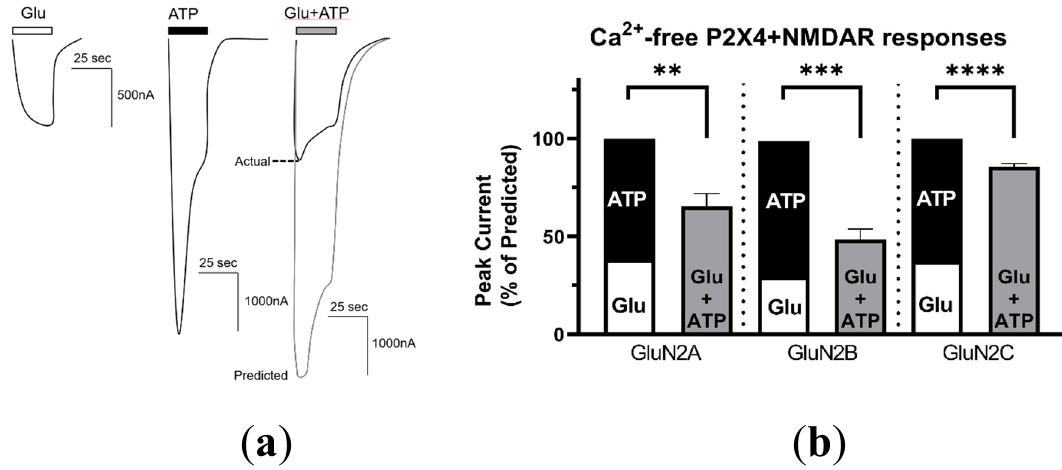
Figure 3. P2X4–NMDAR cross-talk is independent of calcium. ( a ) Representative currents recorded in Calcium-freeRingers’solution(CfRS)fromanindividualoocytecoexpressingP2X4andGluN2B-containing NMDARs responding to: Glu (2 µ M), ATP (5 µ M), or Glu and ATP (2 µ M and 5 µ M, respectively). The predicted additive response (grey line) is calculated as the sum of the individual Glu and ATP induced currents. ( b ) Bar graphs representing the predicted and actual responses obtained from coapplication of agonists, normalized to the sum of the separate Glu and ATP responses for each oocyte. For GluN2A, coactivation produced a statistically lower response than the predicted response ( p < 0.01; paired t -test; n = 10). The same result was observed for GluN2B ( p < 0.001; paired t -test; n = 9) and GluN2C ( p < 0.0001; paired t -test; n = 28) coactivation. Furthermore, the degree of inhibition was not significantly